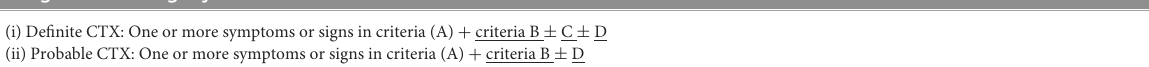
TABLE 3 Diagnostic criteria and categories for CTX, based on Sekijima’s (17) and modified from Stelten’s criteria (6). Diagnostic category: